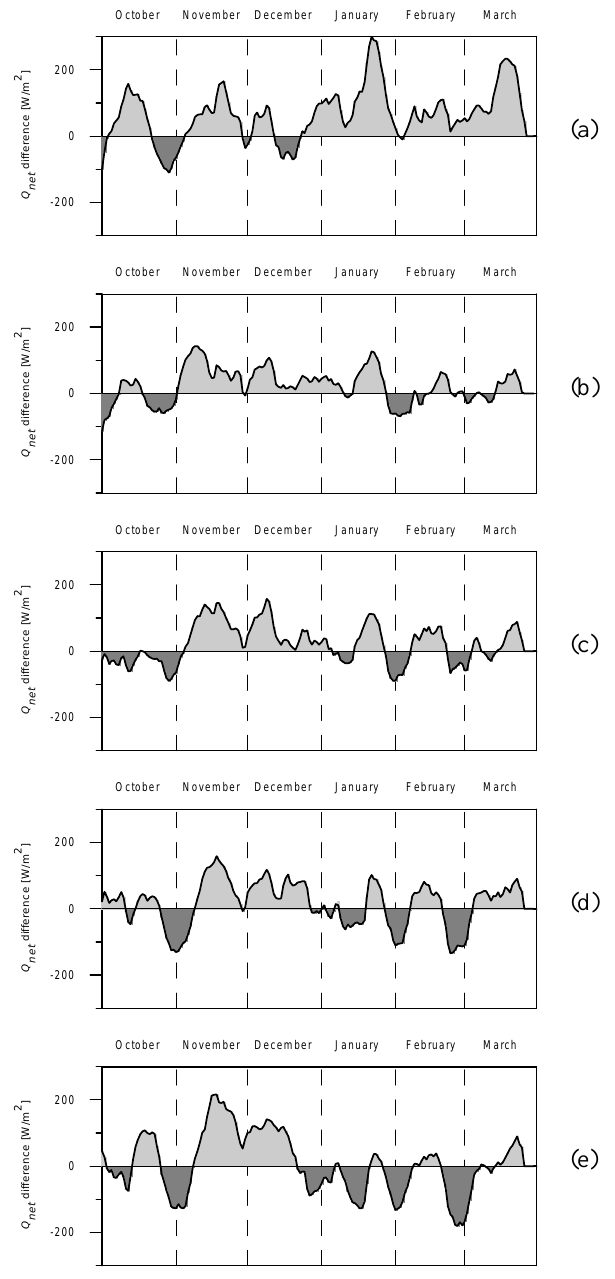
Fig. 4. Difference in the daily heat fluxes between 1999/2000 and 2000/2001 for the period October-March at five locations: south- ern Adriatic at 41.5 ◦ N, 17.5 ◦ E (a) ; NW Ionian at 37.5 ◦ N, 16 ◦ E (b) ; southern Tyrrhenian Sea at 39 ◦ N, 13 ◦ E (c) ; central Tyrrhenian Sea at 42 ◦ N, 10.5 ◦ E (d) and northern Ligurian Sea at 44 ◦ N, 9 ◦ E (e) . Positive areas (in light grey) indicate greater heat loss during 1999/2000, while negative areas (in dark grey) indicate greater heat loss during